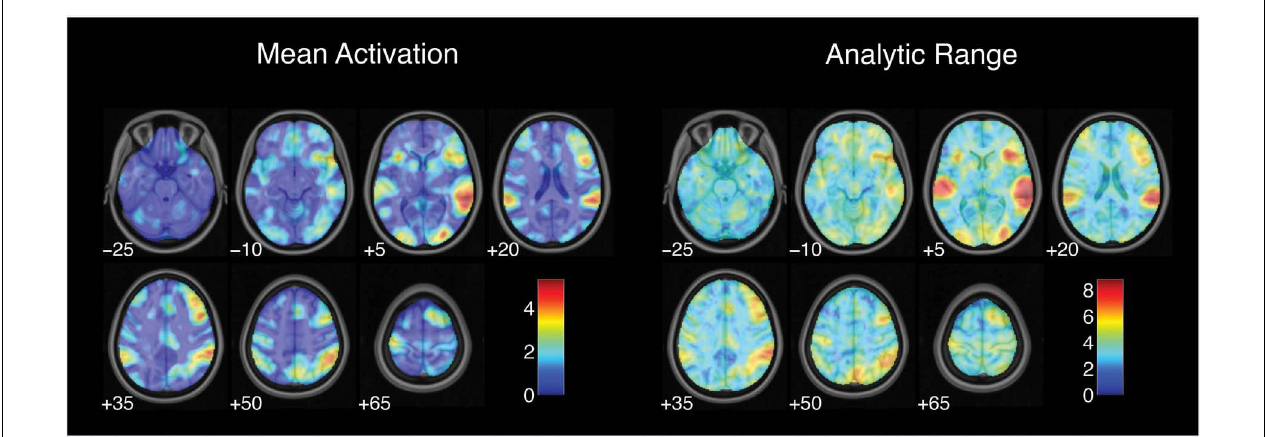
pipelines. Images are presented in neurological orientation, with the left hemisphere displayed on the left. Note that color scales differ across panels.